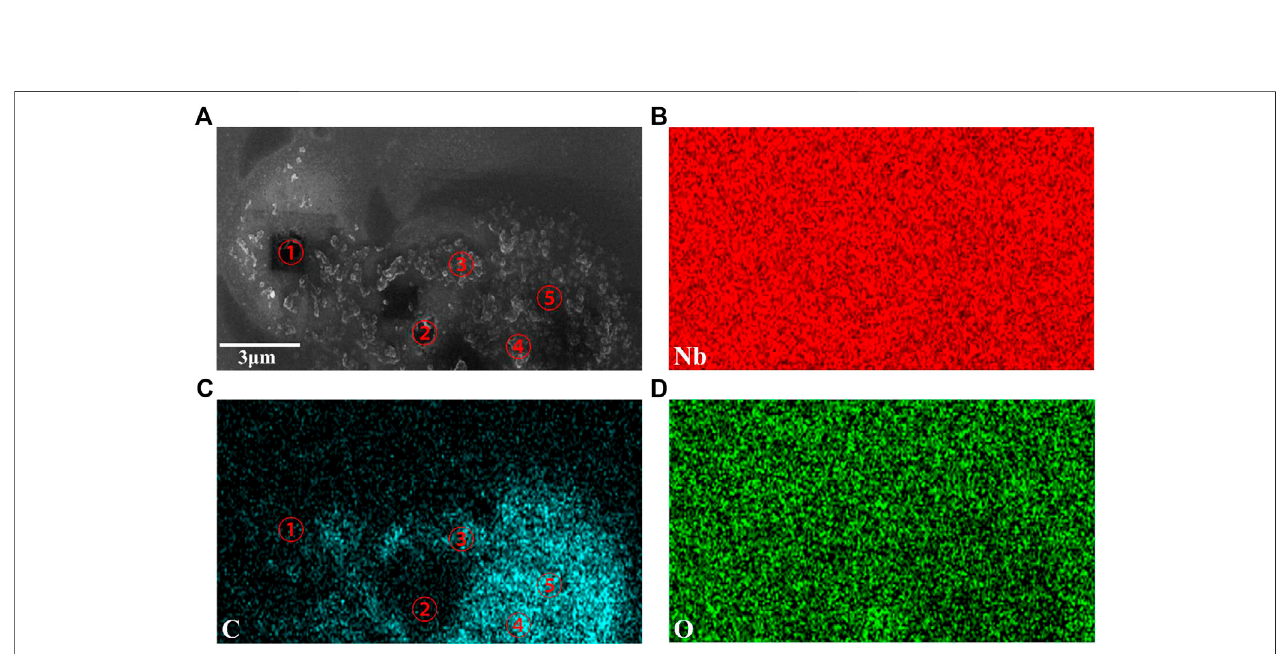
FIGURE 5 | (A) SEM image of graphene on LN (B) – (D) EDS mapping for Nb, C, and O elements in the region shown in (A) .